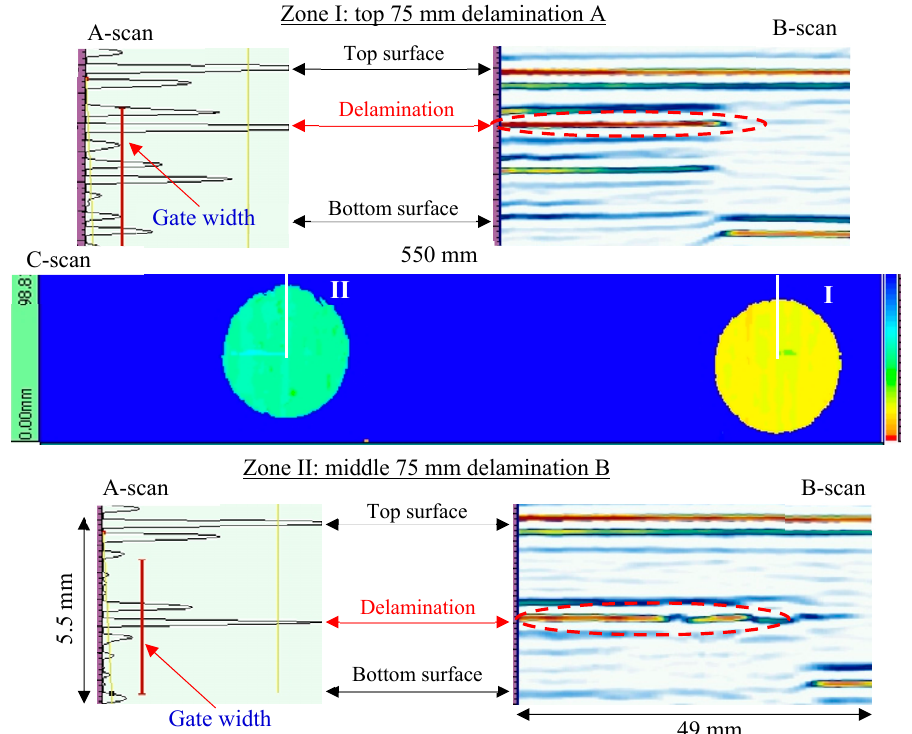
Figure 8. NDT results of the first inspection area on the unidirectional [0] 30 CFRP composite plate: top and middle 75 mm delaminations.